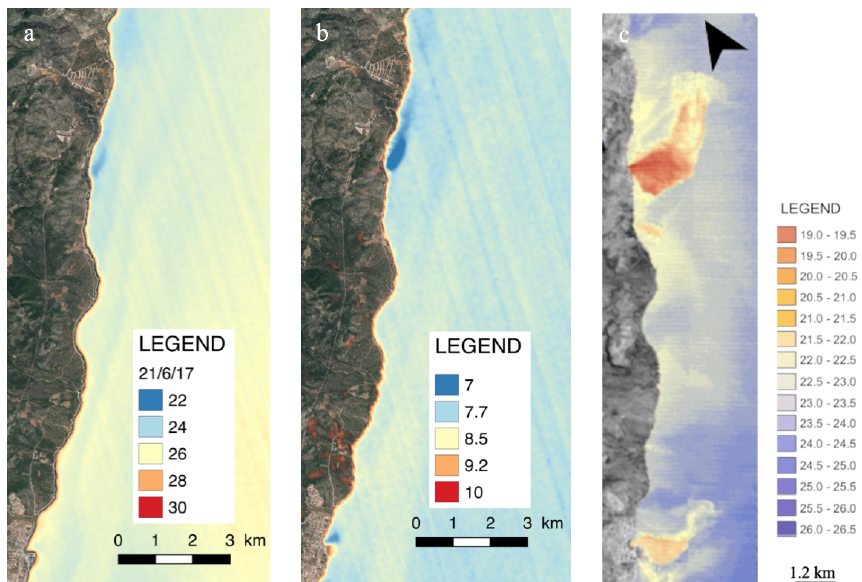
Figure 5. (a) Serra d’Irta single image map using an image taken on 21 June 2017. One spring in the middle of the Torre Badum spring was identified. (b) Serra d’Irta standard deviation (SD) map using 10 cloud-free images acquired between 2017 and 2018. In total, two springs in Serra d’Irta, in the south of the Les Fonts beach at the Alcossebre spring and in the middle at the Torre Badum spring, were identified. (c) Image modified from Mejías et al. (2012), where SGD springs were identified using aerial thermal infrared images. © Google Earth